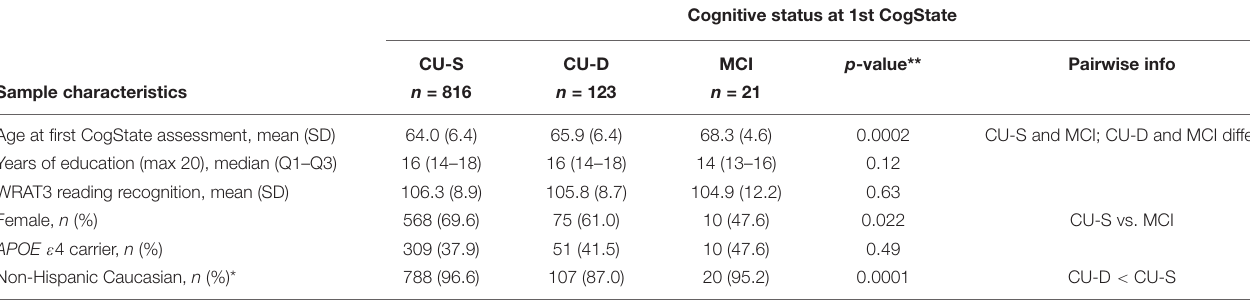
TABLE 2 | Sample characteristics by cognitive status at first CogState assessment for subset used in analyses using CogState data. Cognitive status at 1st CogState CU-S CU-D